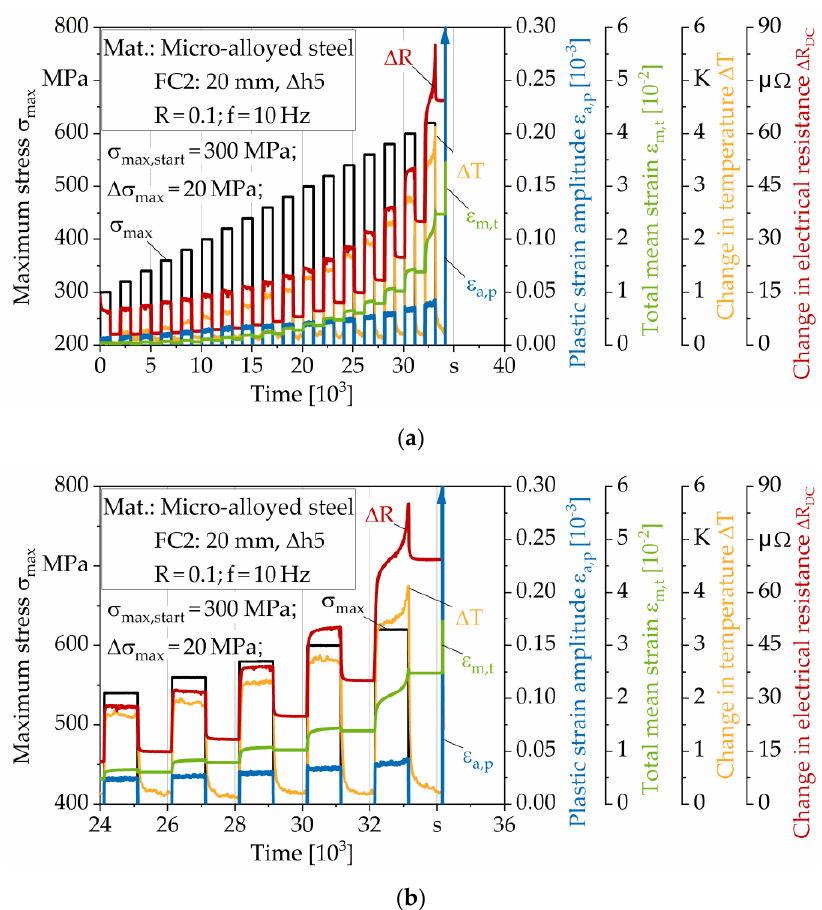
Figure 7. ( a ) Multiple amplitude (load increase) test (LIT) with load-free intermediate steps for hot flat rolled sheet material; thickness: 20 mm; pass reduction: Δ5 mm. ( b ) Scaled to last load steps.